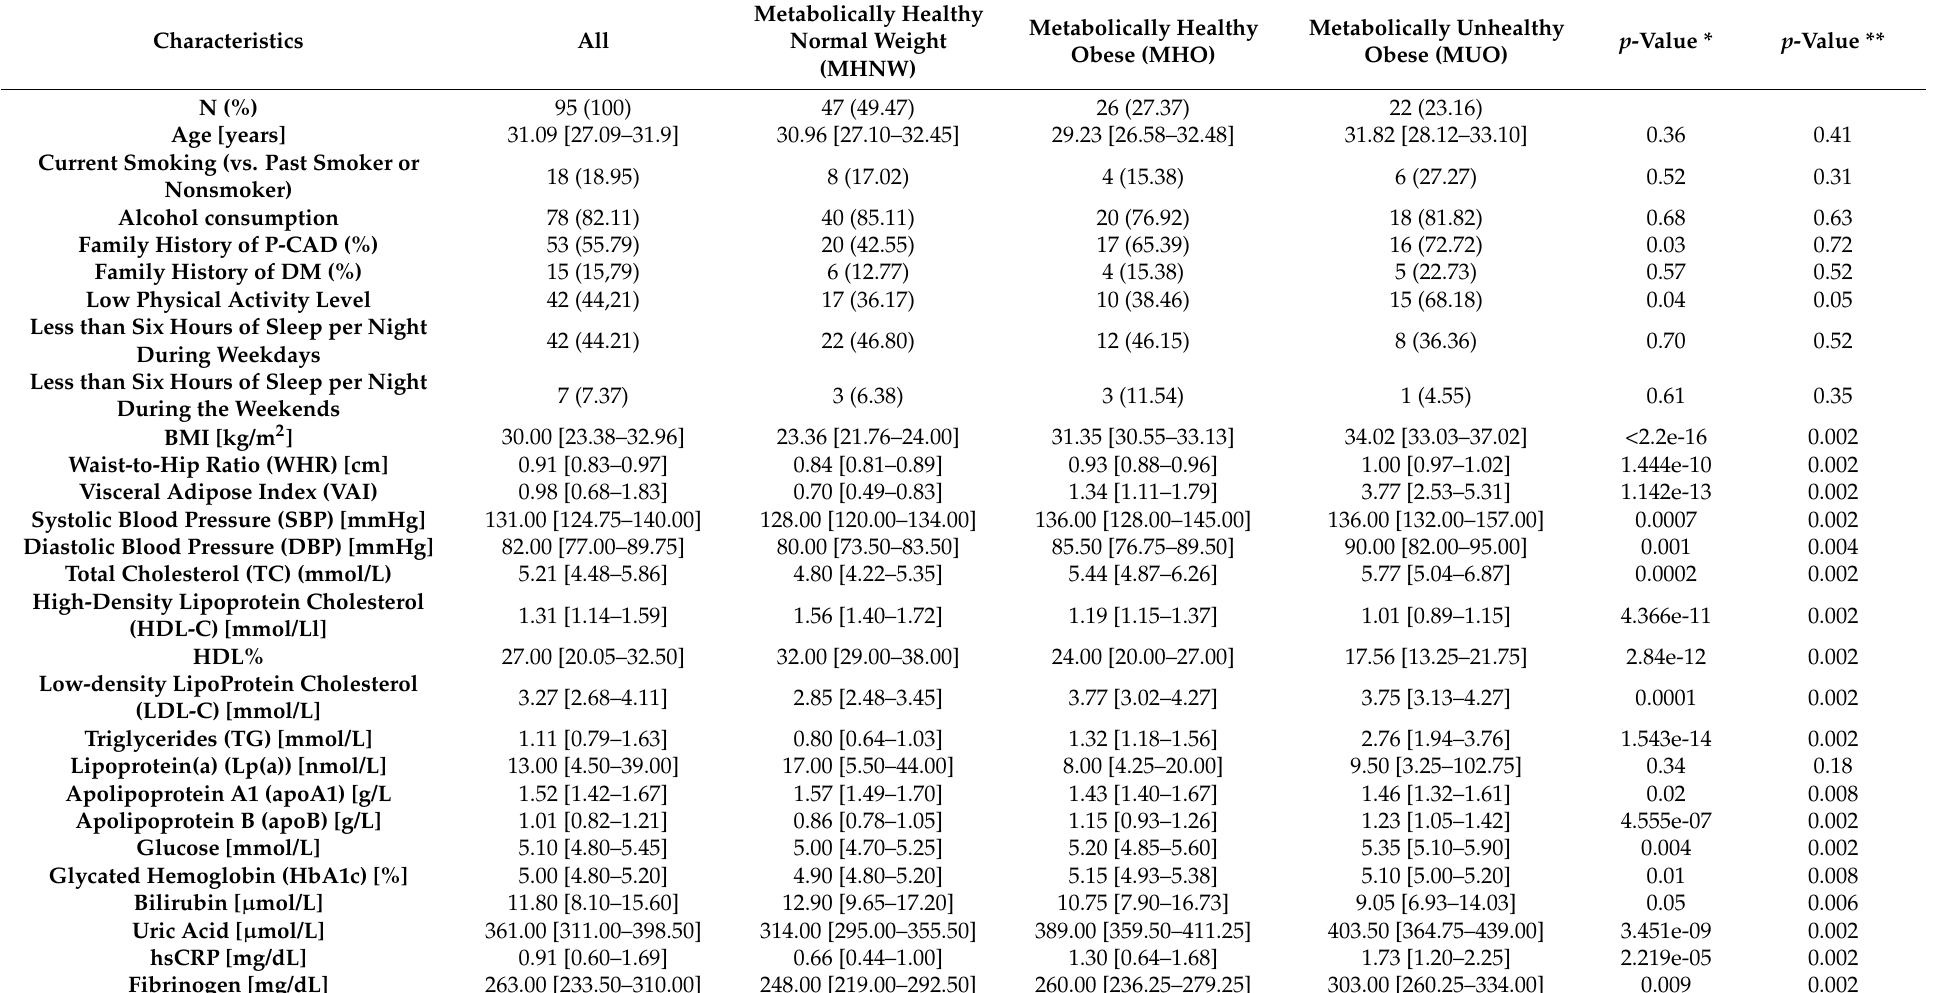
Table 2. Clinical and demographic characteristics of study participants according to metabolic